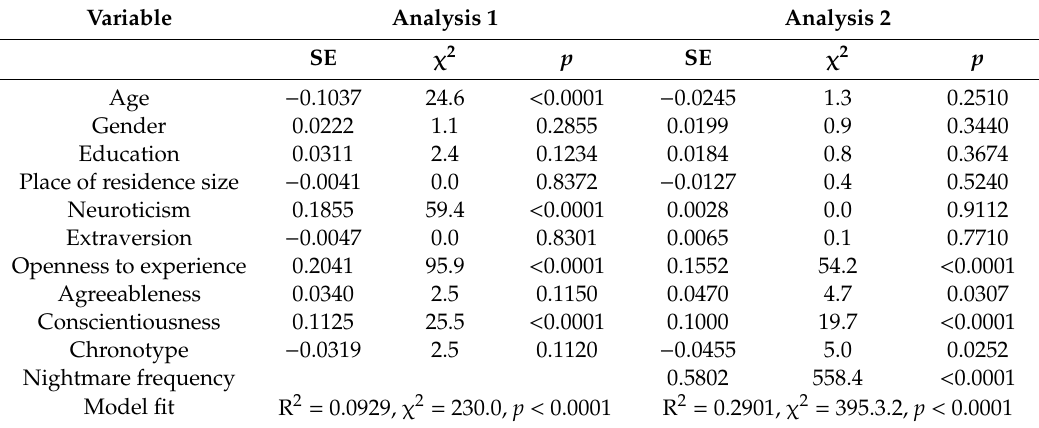
Table 6. Ordinal regressions for dream recall frequency ( n = 2479).